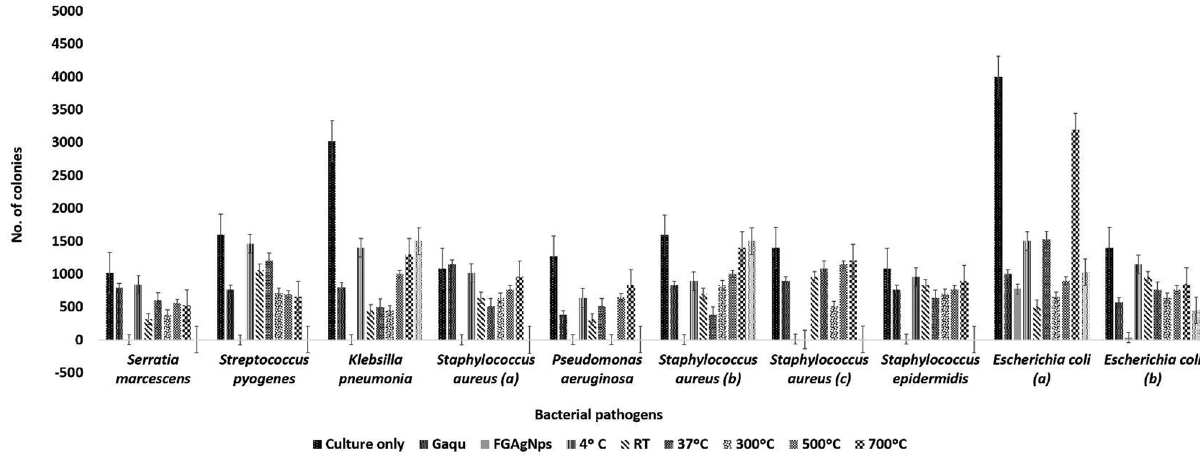
Figure 4: Antibacterial e ffi cacy of green - synthesized silver nanoparticles using A. sativum clove extract via the spread plate agar